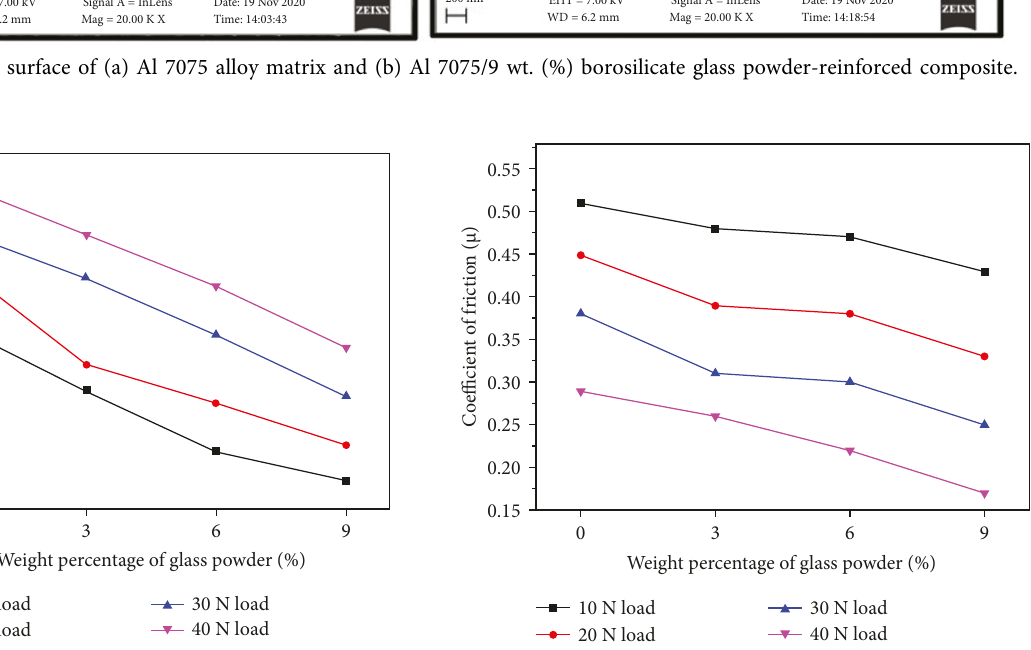
Figure 11: Variation of coefficient of friction with the reinforce- ment contained at the different applied load